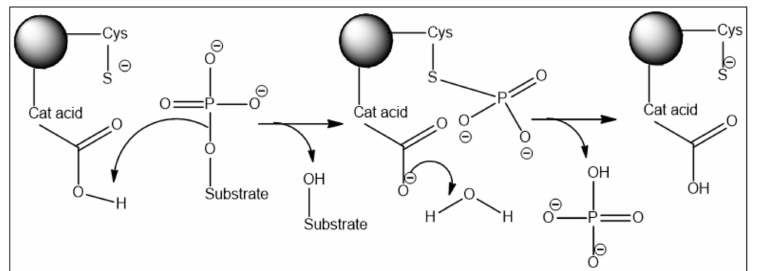
Figure 1. Two-step reaction mechanism of the Cdc25 phosphatases with a covalent phospho-cysteine